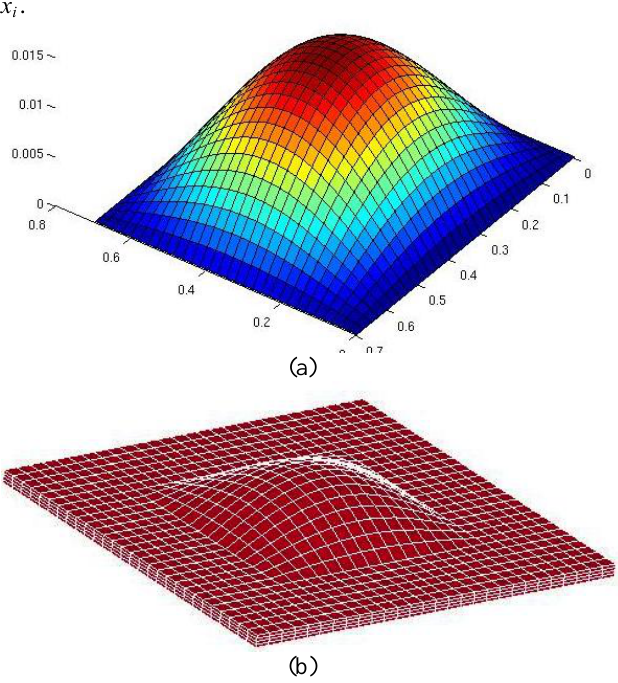
Fig. 4. (a) 3-DV basis shape corresponding to top surface bulge (exaggerated for visualization), (b) Full plate show- ing the domain for shape optimization of the